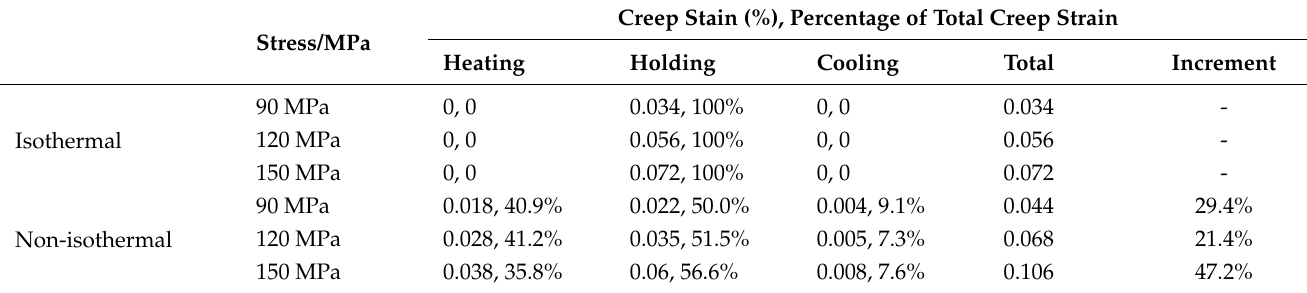
Table 1. The isothermal and non-isothermal creep strains of the AA2024 aluminum alloy.